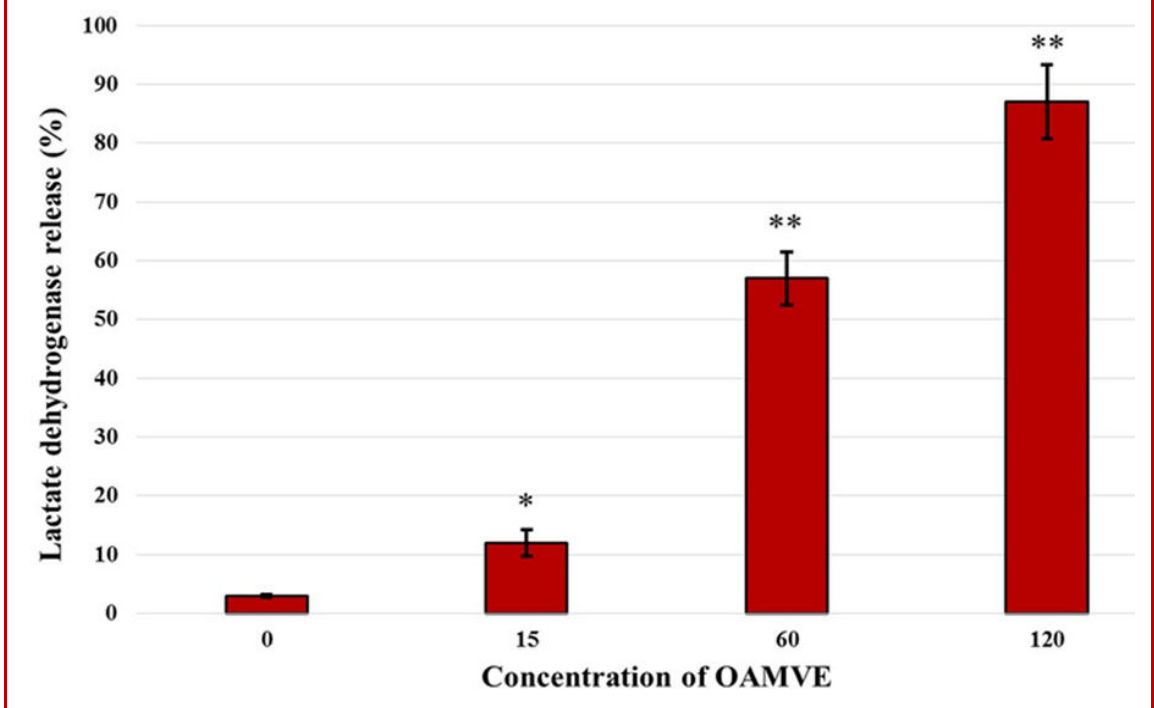
Figure 2: LDH release assay; HeLa cells were treated with various concentrations of OAMVE for 24 hours, LDH release was detected by LDH assay kit; Each point is the mean ± SEM of three experiments (*p<0.05; **p<0.01 v.s control